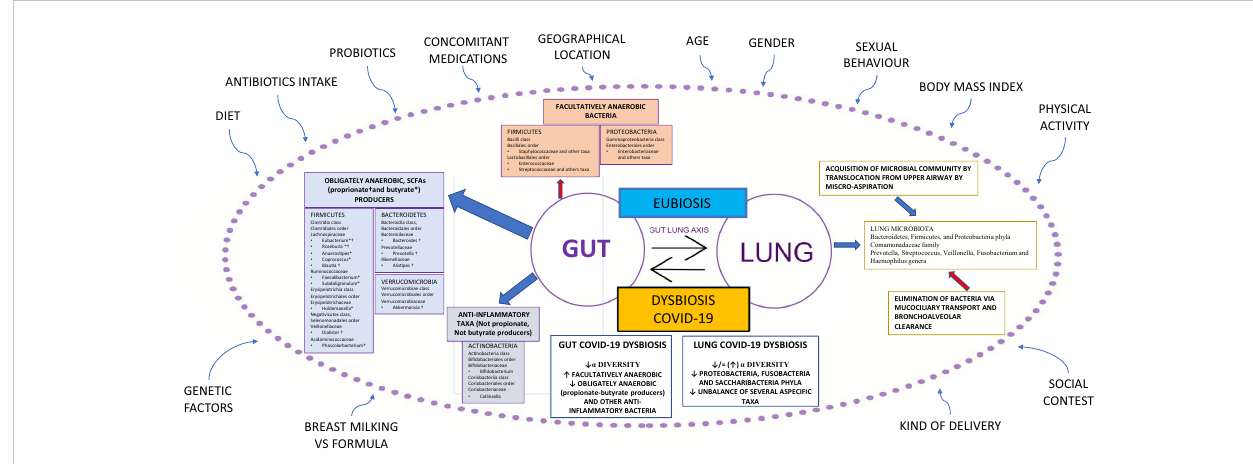
FIGURE 1 Gut-lung axis microbiota in COVID-19. This fi gure shows a summary of the gut-lung axis and its alterations during COVID-19. Left: the gut microbiota taxa obligately anaerobic short-chain fatty acids (propionate and butyrate) producers and anti-in fl ammatory taxa, not propionate and butyrate producers. Upper: facultatively anaerobic bacteria. Right: the homeostasis of the lung microbiota, resulting from acquisition (blue arrow) and elimination (red arrow) clearance. Bottom: the most signi fi cant alterations detected in gut and lung microbiota during COVID-19. All around, the confounding factors are strictly related to Microbiota. BMI: Body Mass Index; ° indicates propionate-producing bacteria, * indicates butyrate- producing bacteria, Upward arrows “ ↑ ” : increase; Downward arrows “ ↓ ” :